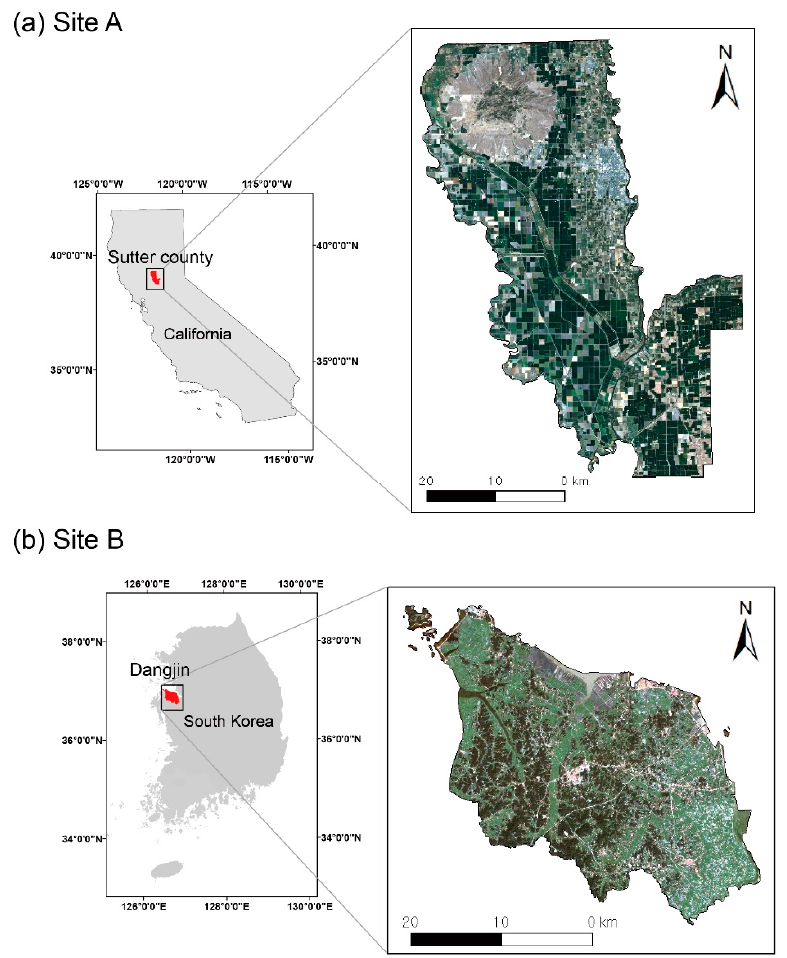
Figure 1. Study area (Landsat 5 true color composition). ( a ) Site A is Sutter County in California State with the Landsat image collected on 26 July 2009 and ( b ) site B is Dangjin in South Korea with the Landsat image collected on 21 September 2003.